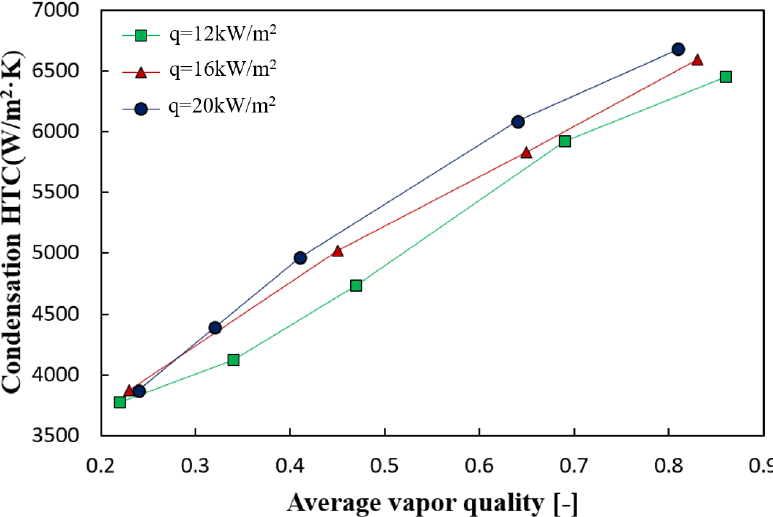
Figure 8. Condensation HTC according to heat flux at various vapor quality condition.